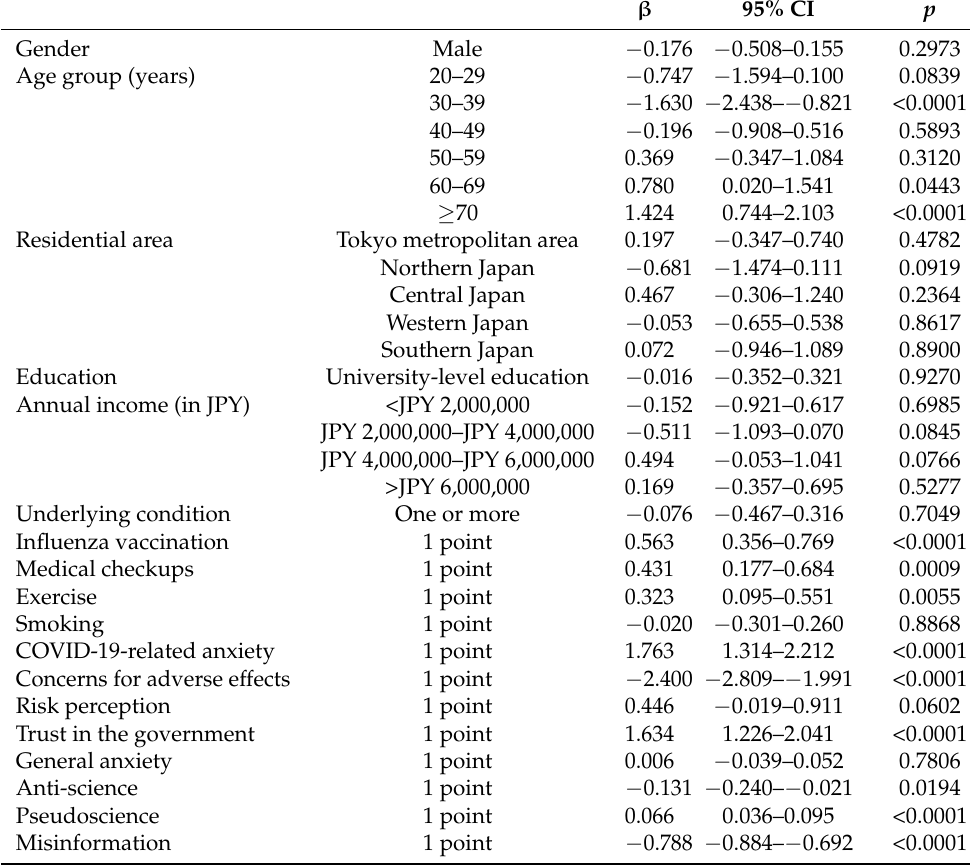
Table 7. Multiple regression for vaccination attitude in September